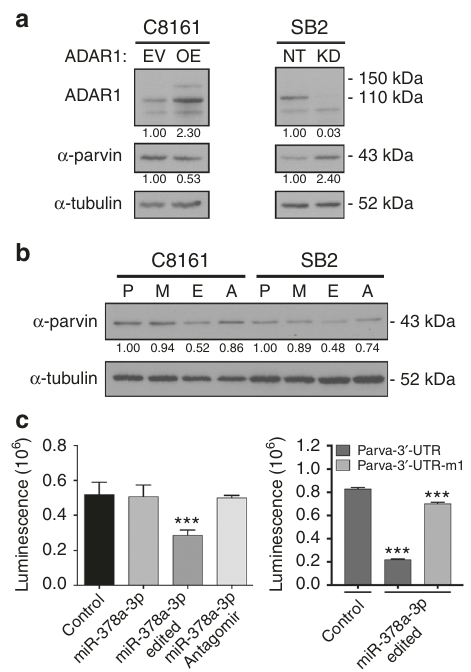
Fig. 2 Regulation of α -parvin by miR-378a-3p. a Western blot analysis of C8161 and SB2 cells after overexpression or silencing of ADAR1, respectively for the expression of α -parvin. A 0.5-fold reduction in α -parvin protein expression was observed in C8161- ADAR1 overexpressing (OE) cells, whereas an increase of 2.4 fold was seen in SB2- ADAR1 knockdown (KD) cells. ADAR1 and α -parvin proteins are inversely expressed. b Western blot analysis demonstrating a speci fi c regulation of α -parvin by edited miR-378a-3p (E) but not by the wild-type (M) form or its antago- miR ( A ). P represents parental cells. a , b are representative of three independent biological samples. c Luciferase expression driven by 3 ′ -UTR of PARVA is decreased following expression of edited miR-378a-3p but no change was observed when wild-type miR-378a-3p was expressed (left panel). No effect was observed when the binding site at the 3 ′ -UTR of PARVA was mutated (right panel). The data are shown as the means ± S.D., n = 6 (*** P <